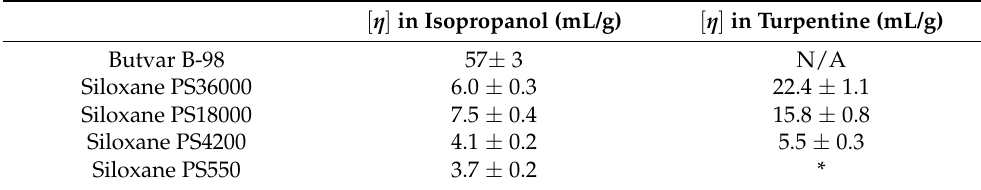
Table 2. A comparison of the [ η ] values obtained for all the tested polymers.